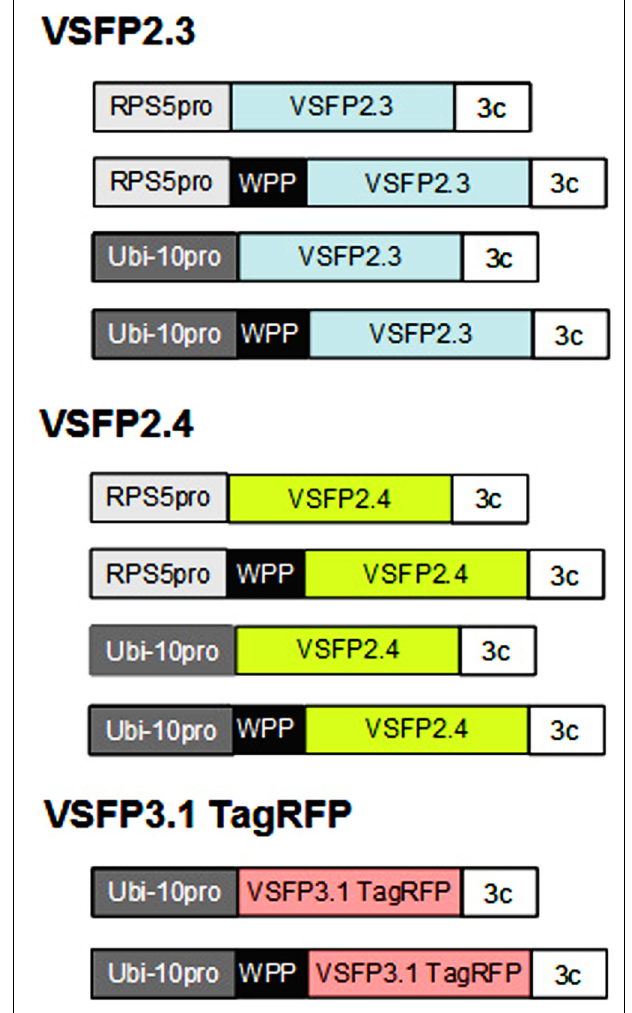
FIGURE 1 | Constructs for expressingVSFPs in plants. Genes encoding voltage-sensitive fluorescent proteinsVSFP2.3,VSFP2.4 (color of donor chromophore shown), andVSFP3.1TagRFP ( Figure 2 ) were placed under the control of either the Arabidopsis RPS5 promoter